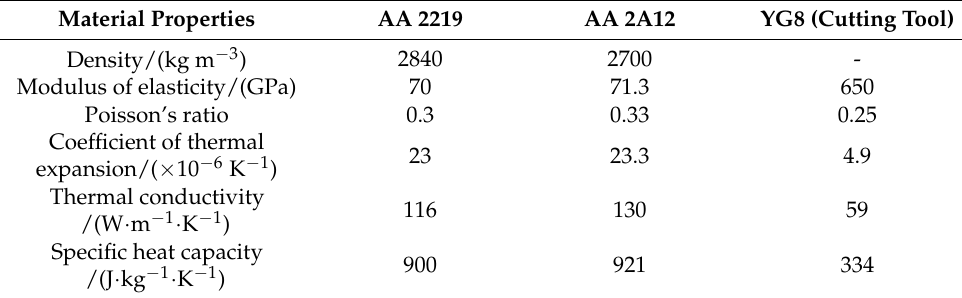
Table 7. Material parameters for the analysis.